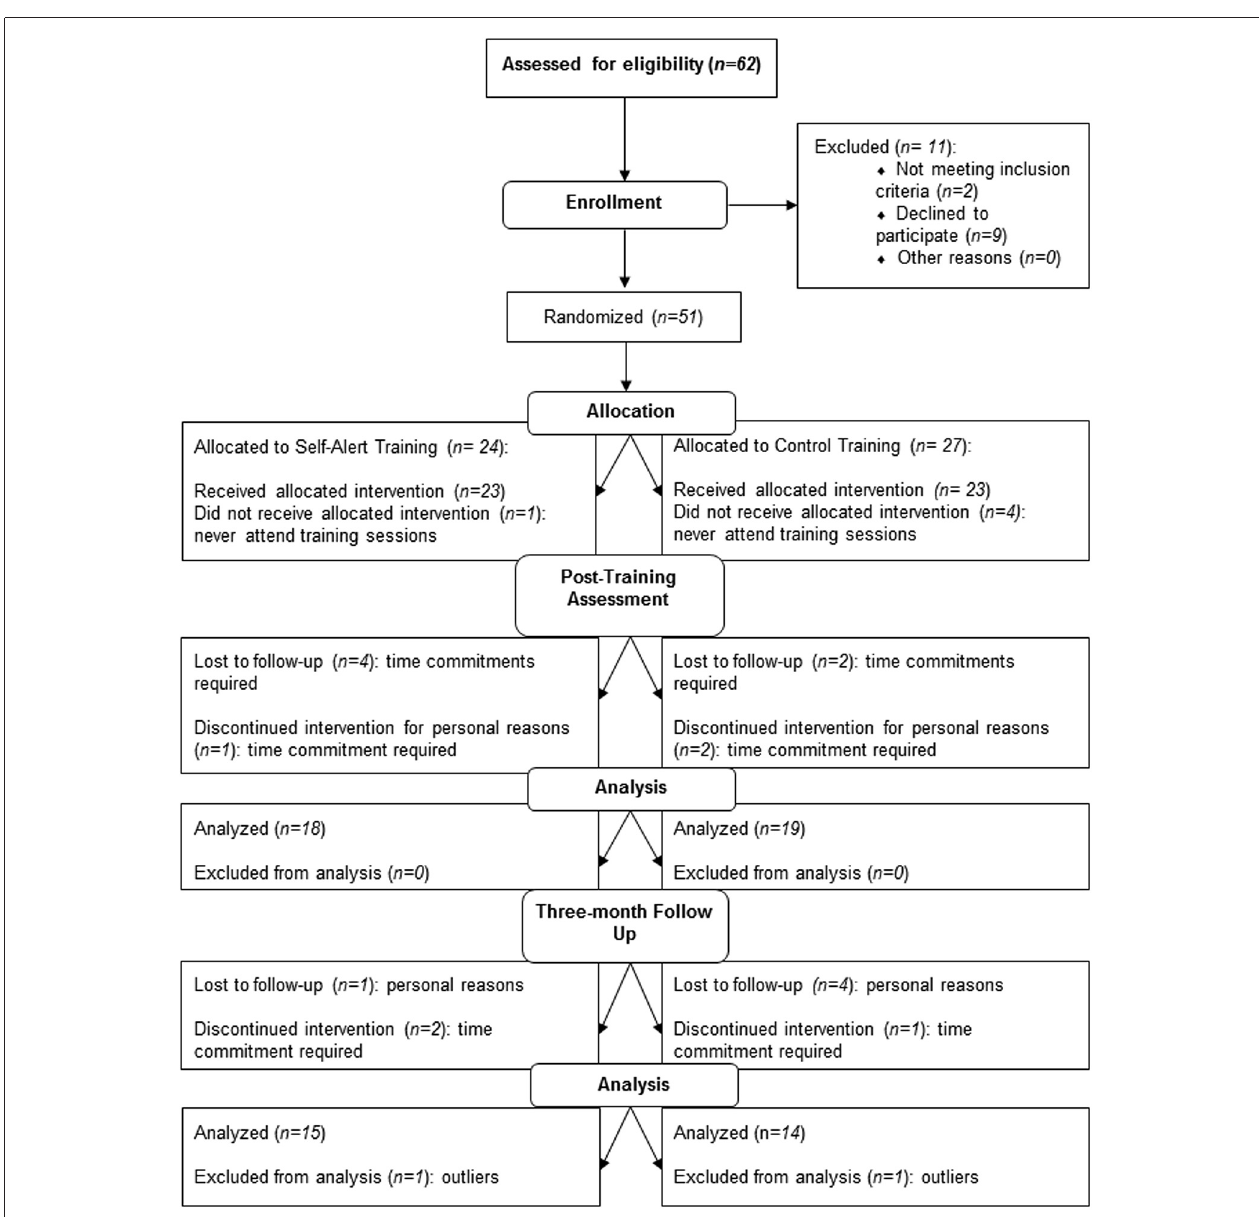
FIGURE 1 | Consolidated Standard for Reporting Trials (CONSORT) diagram showing the flow of participants through the trial and reasons for dropout . SAT = Self-Alert Training; CT = Control Training.